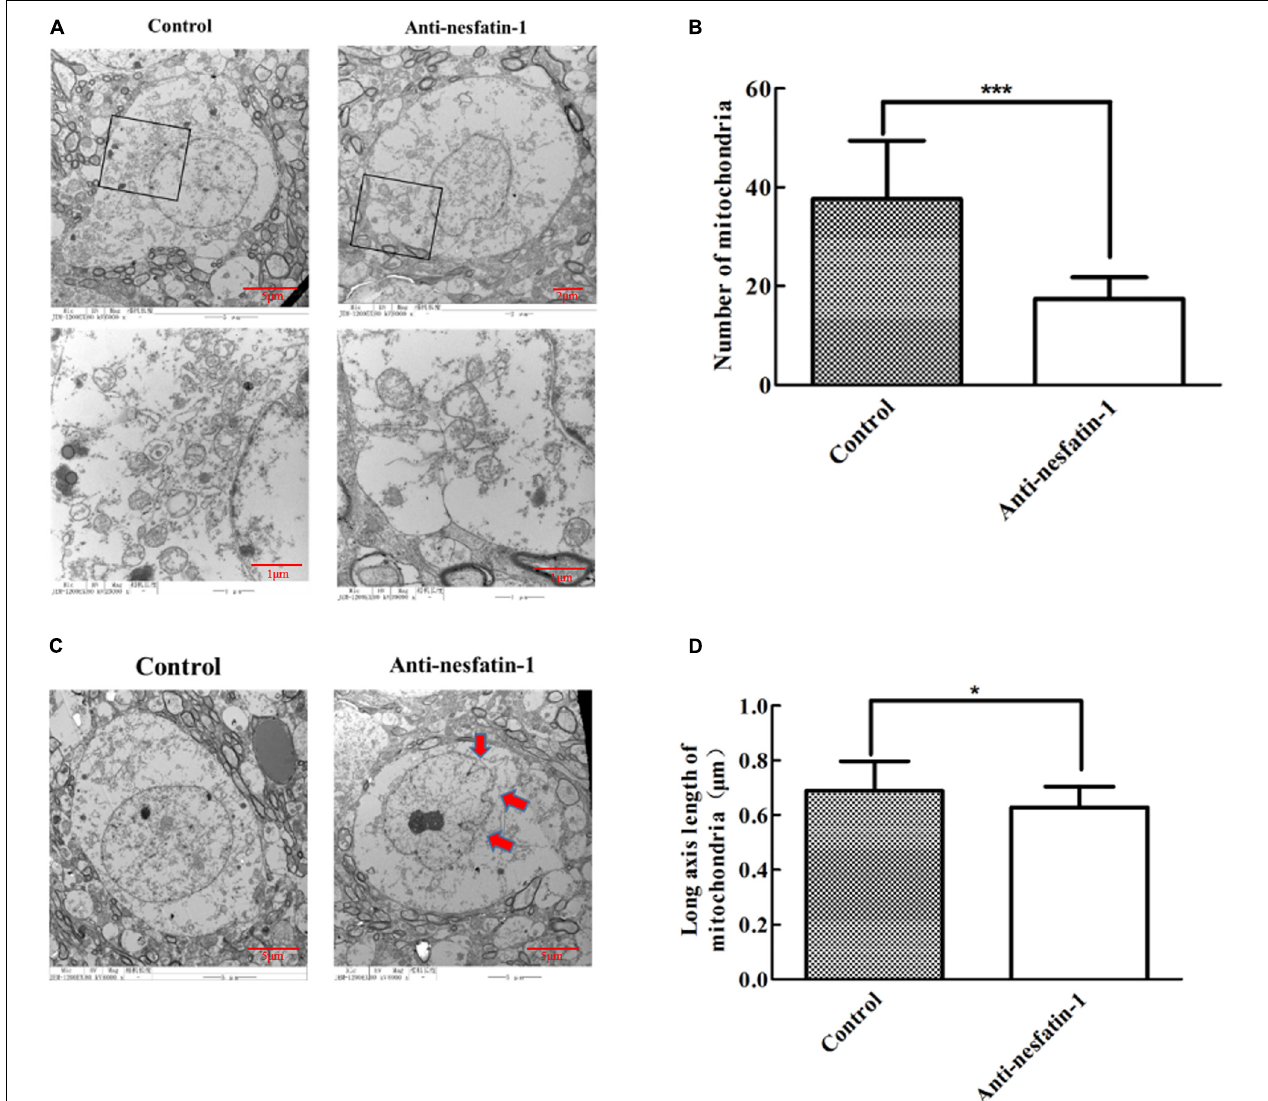
FIGURE 6 | Anti-nesfatin-1 antibody treatment induced mitochondrial depletion and nuclear shrinkage in dopaminergic neurons ( n = 6). (A) Mitochondria in dopaminergic neurons in control and anti-nesfatin-1 antibody-treated mice. (B) A summary of the data showing the numbers of mitochondria in the dopaminergic neurons of control and anti-nesfatin-1 antibody-treated mice. (C) The anti-nesfatin-1 antibody induced nuclear shrinkage. The red arrows indicate the shrunken nuclei. (D) A summary of the data showing the long axis length of mitochondria in the dopaminergic neurons of control and anti-nesfatin-1 antibody-treated mice. Each value represents the mean ± SD, n = 6; *** p < 0.0001, and * p < 0.05. MAB 201, non-immune anti-mouse IgG antibody; SHU 9119, MC4R receptor